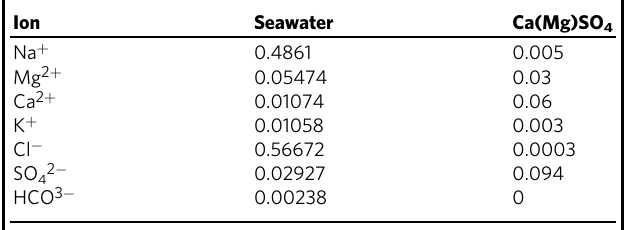
Table 2 Values of soil water chemistry used in SOIL8MIN model to determine unfrozen water content (S L ), a semi- empirical model that includes the soil properties and the geochemical composition of soil